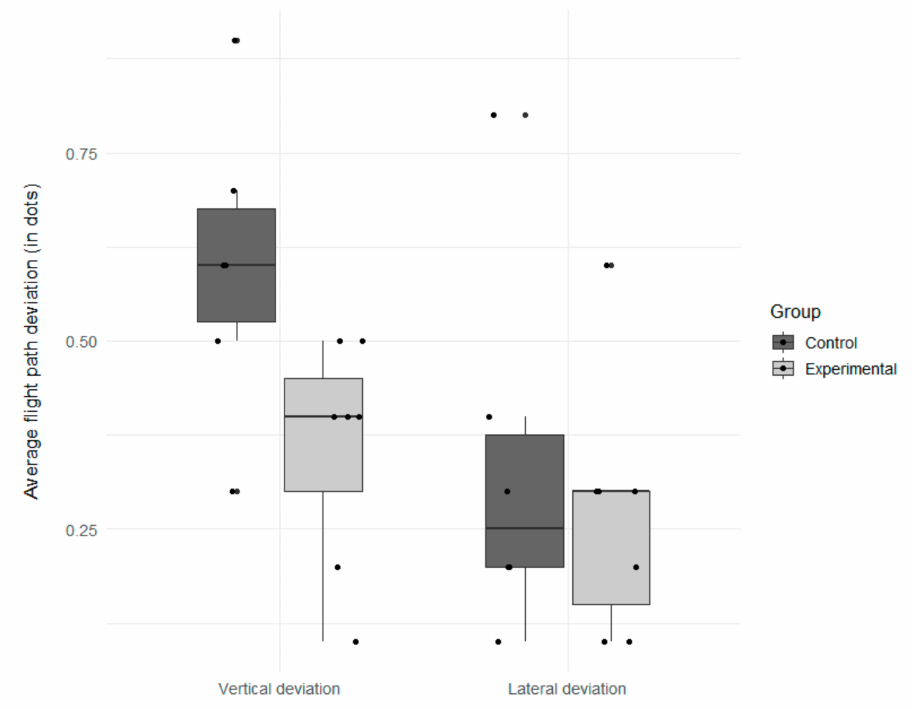
Figure 10. Absolute lateral and vertical deviations in dots (lower is better) during the approach (post-training session) for the experimental group and the control group (dots represent individual data). The pilot who did not manage to stabilize the approach has not been included since he aborted the